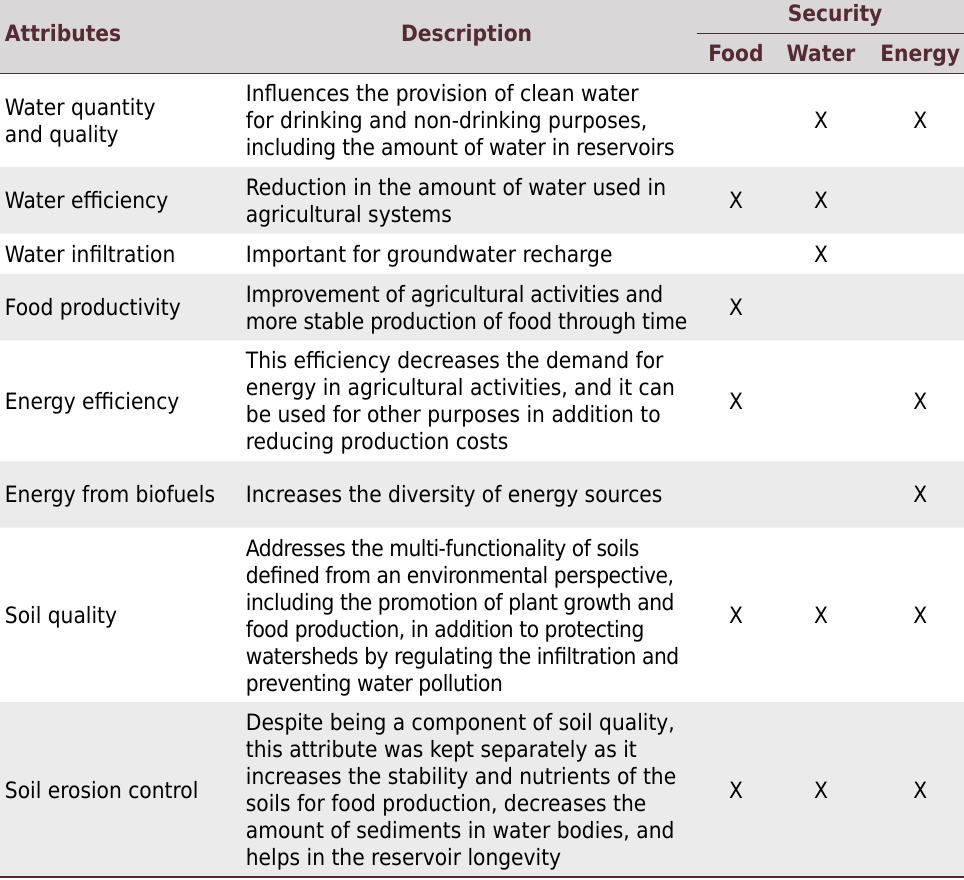
Table 3. Select attributes for each element of the F-W-E Nexus, and their description, for which we could measure the impact of rural conservation practices Attributes